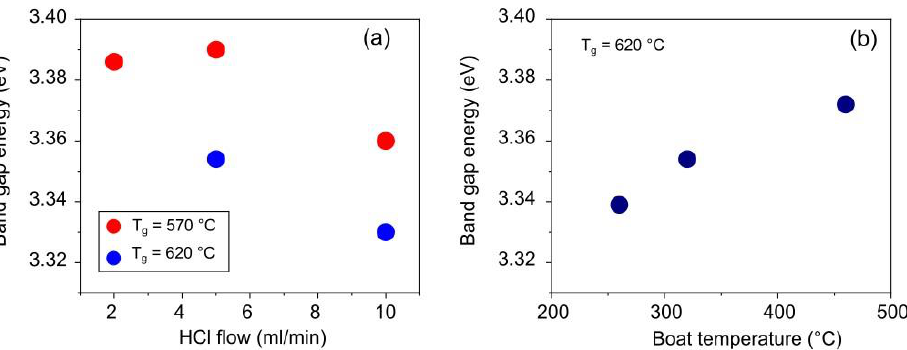
Figure 8. ( a ) Squared absorption coefficient plotted as a function of photon energy for layers grown at 570 °C at three different flows of HCl through the boat with indium. Temperature of the boat kept constant at 320 °C. The inset shows the spectrum for the GaN template for reference. The dashed lines are a guide to the eye. ( b ) Graphs for layers grown at 620 °C for different temperatures of the boat with metallic indium. HCl flow over indium melt was kept to 5 mL/min.